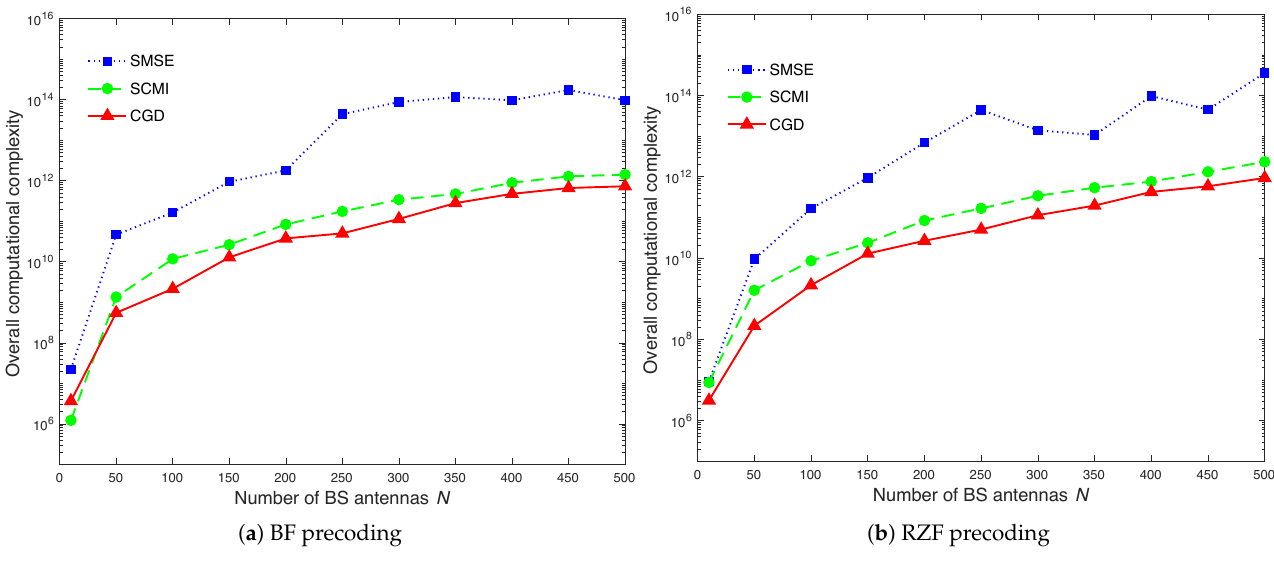
Figure 6. Overall computational complexity versus the number of BS antennas N comparing different training sequence methods corresponding to the pilot length in BF and RZF precoding in the OR model with ω = 5 ◦ , D = 1/2, T = 100 symbols, ρ d = 5 dB and K = 10 users.